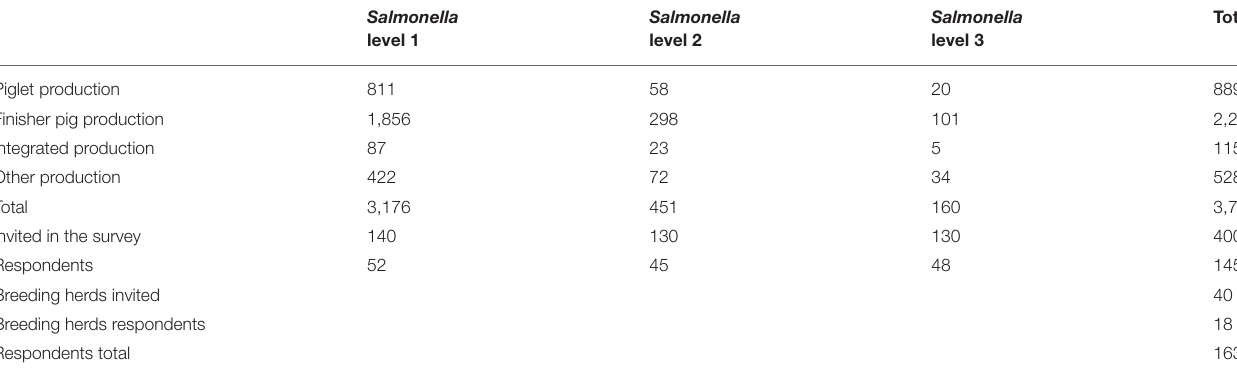
TABLE 4 | Distribution of Danish pig herds and of herds in the sample categorized according to Salmonella